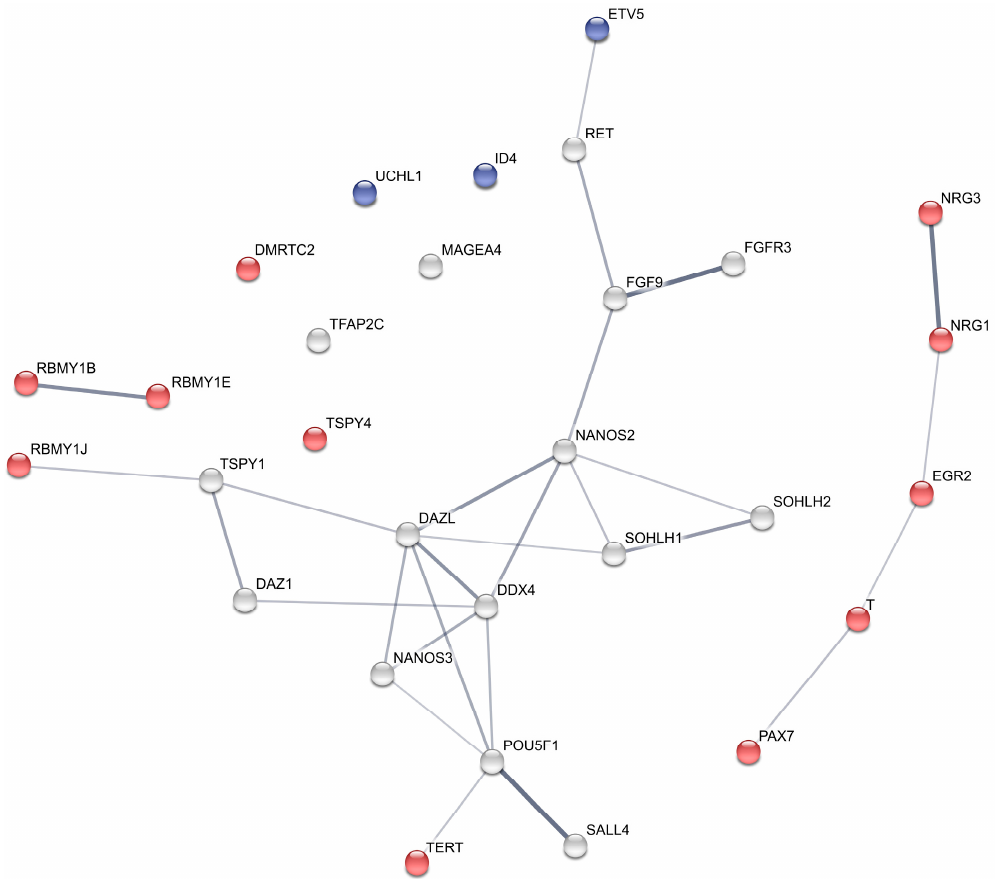
Figure 3. Protein interaction network of differentially expressed gonocyte and spermatogonial marker genes in Ad − /Ad+ and after GnRHa treatment. Protein coding genes which up- or downregulated after GnRHa treatment are represented by red and blue nodes, respectively. STRING was used to predict the protein interaction network [25] with a confidence cut-off of 0.4. Line-weight represents the strength of data support between the predicted